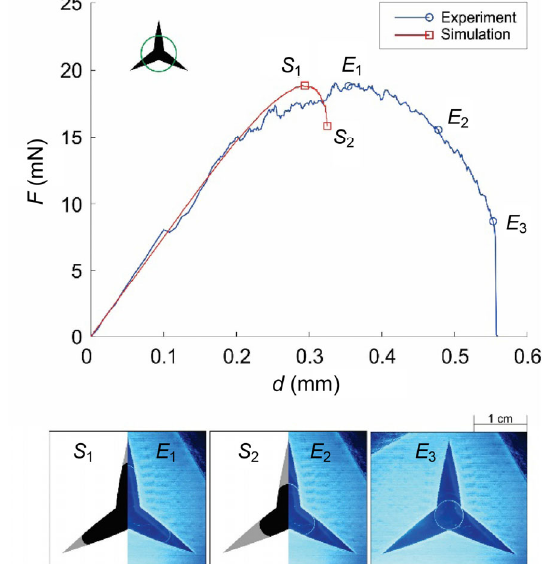
Fig. 15 Dependency of the attracting force on the pull-off distance for a shape composed of two circles. The blue curve represents experimental data, while the red curve is obtained by simulation. The simulation results were fitted to the experimental data by assuming * 9.28 kPa  E and 1 0.030 N m .     Highlighted 12 points ( S 1 , S 2 , S 3 , E 1 , E 2 , E 3 ) refer to the lower part where the real contact area for selected pull-off-states is shown. The green circle in the shape representation depicts the equivalent Holm-radius of the shape. In the photographs of the experiment ( E 1 , E 2 , E 3 ), the actual edge of the contact has been retraced with a semi-transparent white line for better